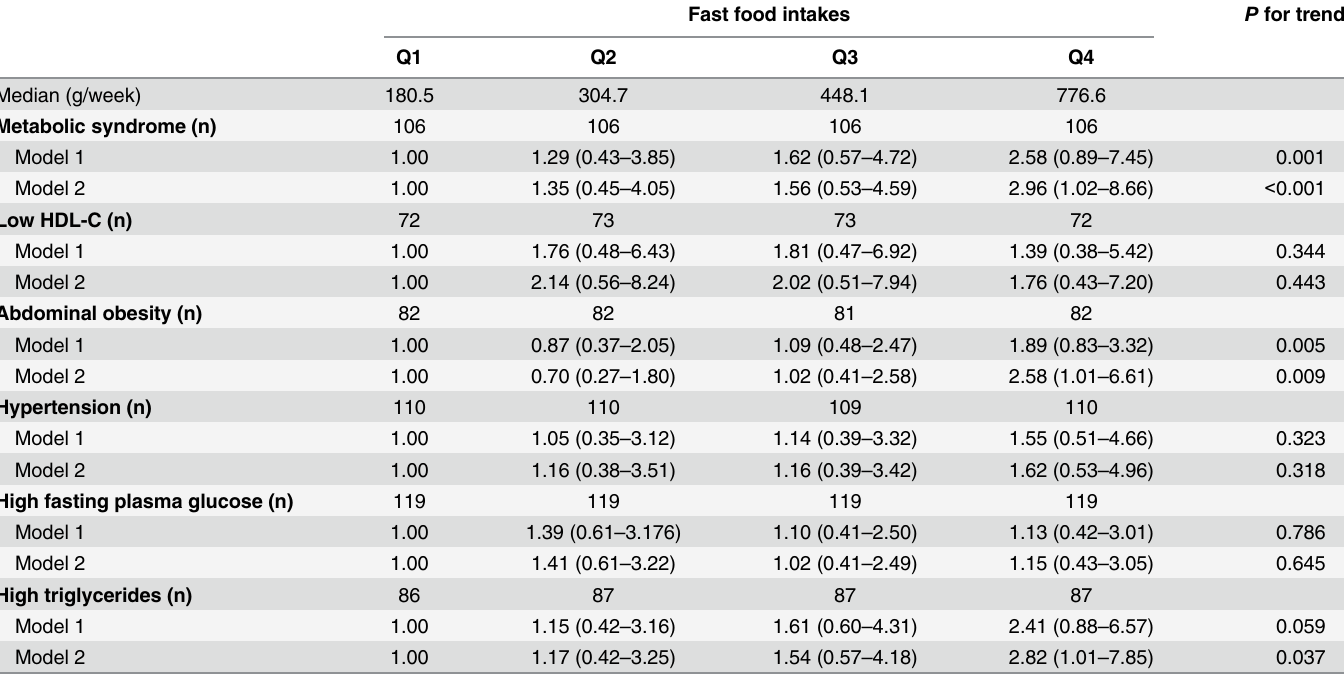
Table 3. Multivariable-adjusted odds ratio (95% CIs) for incident MetS and its components according to quartiles of fast food intake, among chil- dren and adolescents during a 3.6-year